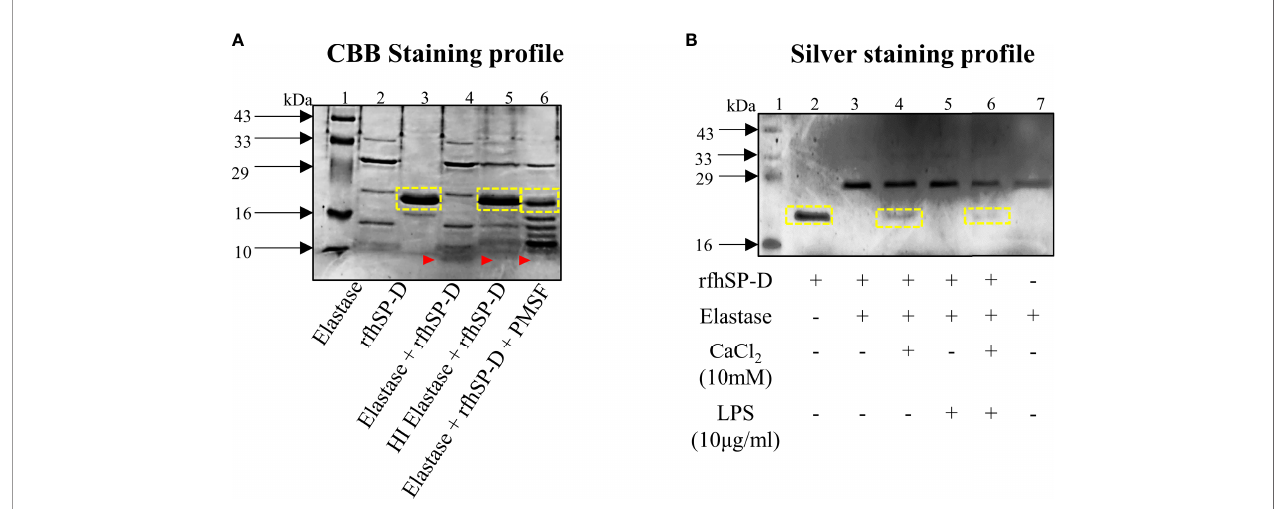
FIGURE 4 | Elastase mediated degradation of rfhSP-D. (A) CBB-stained pro fi le of 2 m g rfhSP-D treated with 2.5 m g elastase for 30 mins at 37°C. Heat-inactivated elastase was used as the negative control. Assessment of partial inhibition of elastase activity by the serine protease inhibitor PMSF (5mM). (B) Effect of CaCl 2 (10mM) and LPS (10 m g/ml) on elastase-mediated degradation of rfhSP-D. Yellow boxes represent band of rfhSP-D; red arrow-heads represent cleaved fragment of rfhSP-D (below 10kDa) due to elastase